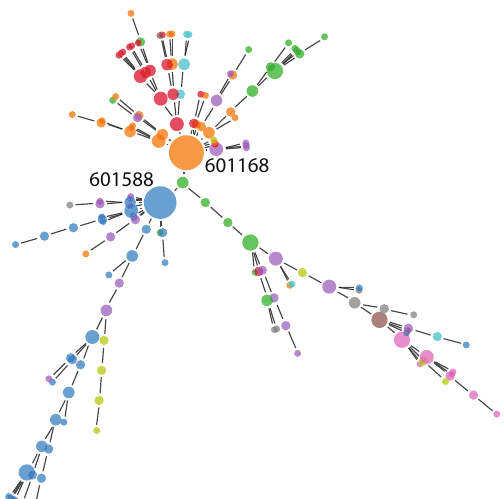
Figure 1. Minimally-spanning tree for the Shanghai Stock Exchange based on partial mutual information between studied stocks. Stocks with the highest node degrees have been named with their ticker symbols. The size of the nodes is proportional to their node degree.